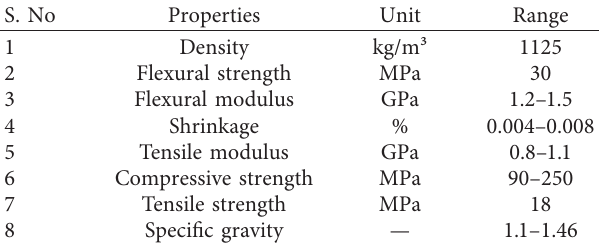
Table 1: Effects of the isophthalic Synthetic Polyester